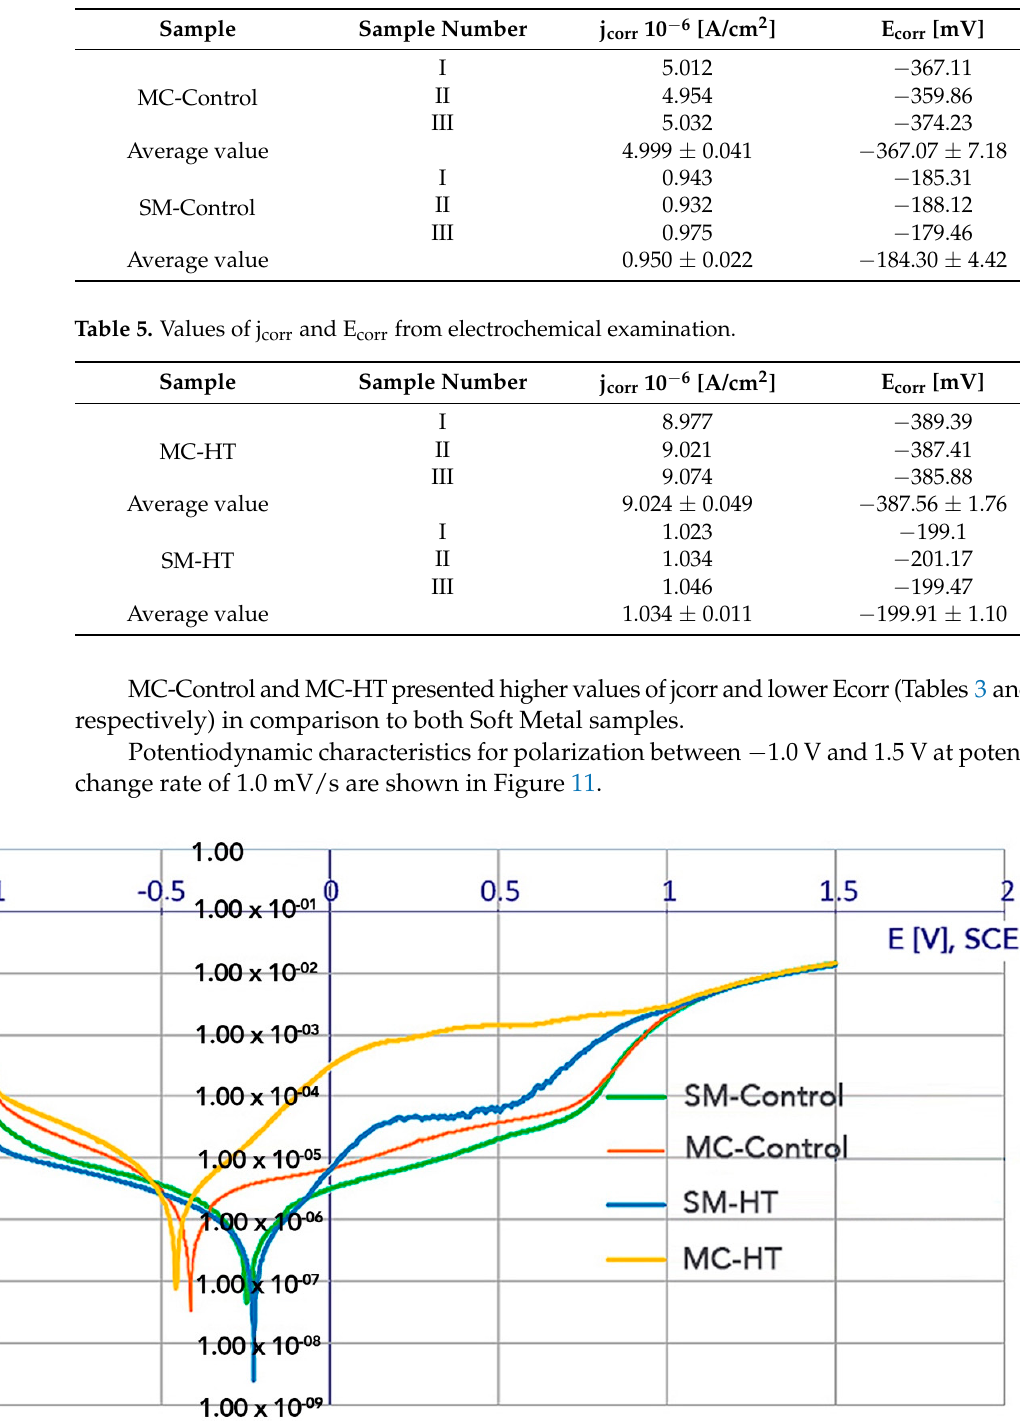
Table 4. Values of j corr and E corr from electrochemical examination.